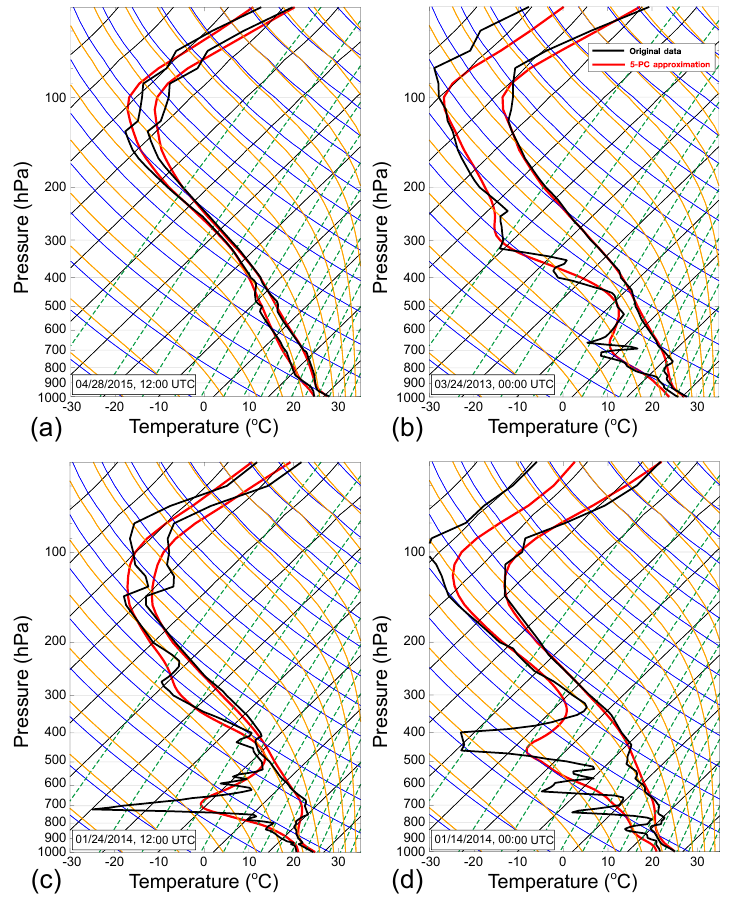
Figure 5. Original radiosonde observations (black) from the Ranai upper-air sounding site and reconstructions of the same radiosonde data using only five principal components (red). Top row panels (a, b) represent thermodynamic structures for which the 5-PC approximation performs well. Bottom row panels (c, d) depict soundings with more complex vertical structure that are more difficult to reproduce with a small number of retained